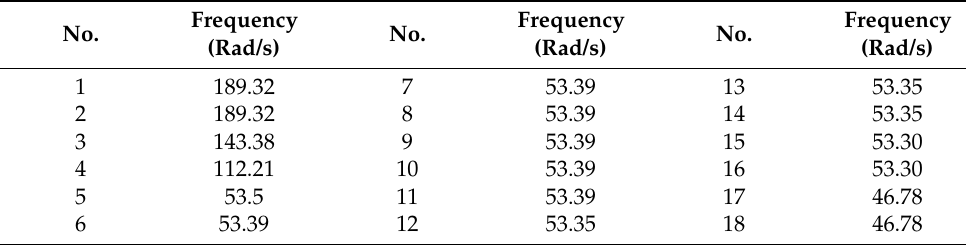
Table 2. Modal frequencies of the rigid-flexible dynamic